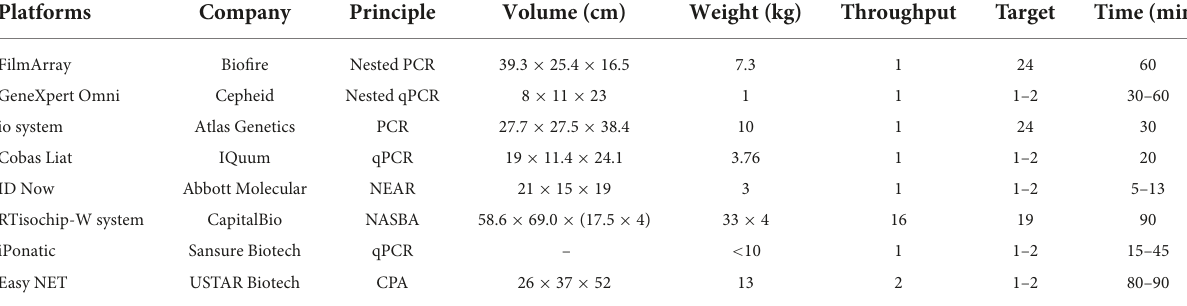
TABLE 4 Comparison of mainstream nucleic acid detection